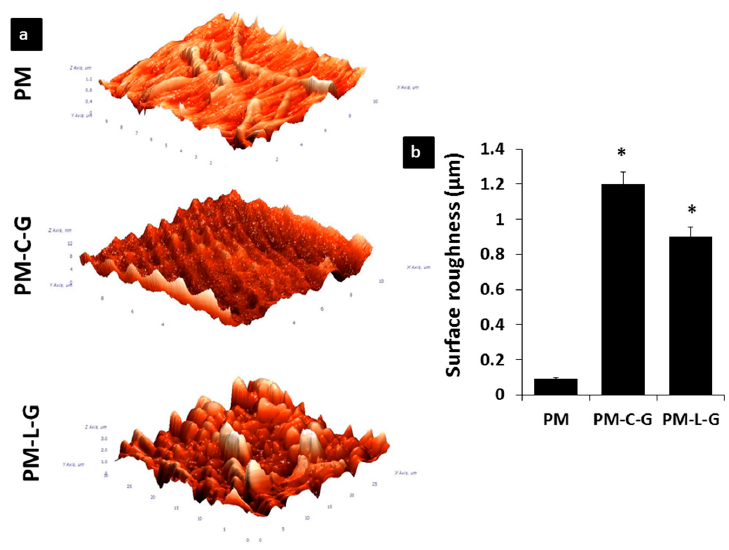
Figure 3. ( a )Atomic Force Microscopy images of PM, PM-C-G, and PM-L-G; ( b ) The bar graph illustrates the surface roughness of nanofiber scaffolds. There was a significant difference in surface roughness of coated PMMA compared to non-coated PM. * indicates significantly higher surface roughness of PM-C-G and PM-L-G compared to PM scaffolds.